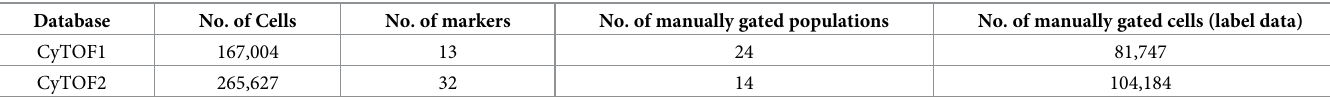
Table 1 delineates two CyTOF benchmark data sets, CyTOF1 and CyTOF2 from healthy human bone marrow mononuclear cells (BMMCs) [38,39]. All proteins markers do not have overlapping in the two datasets. (1) The first, CyTOF1, generated by [38] from one healthy vol- unteer, comprised data of approximately 167,000 cells with 13 markers ) about half of which Table 1. Two CyTOF benchmark data sets for